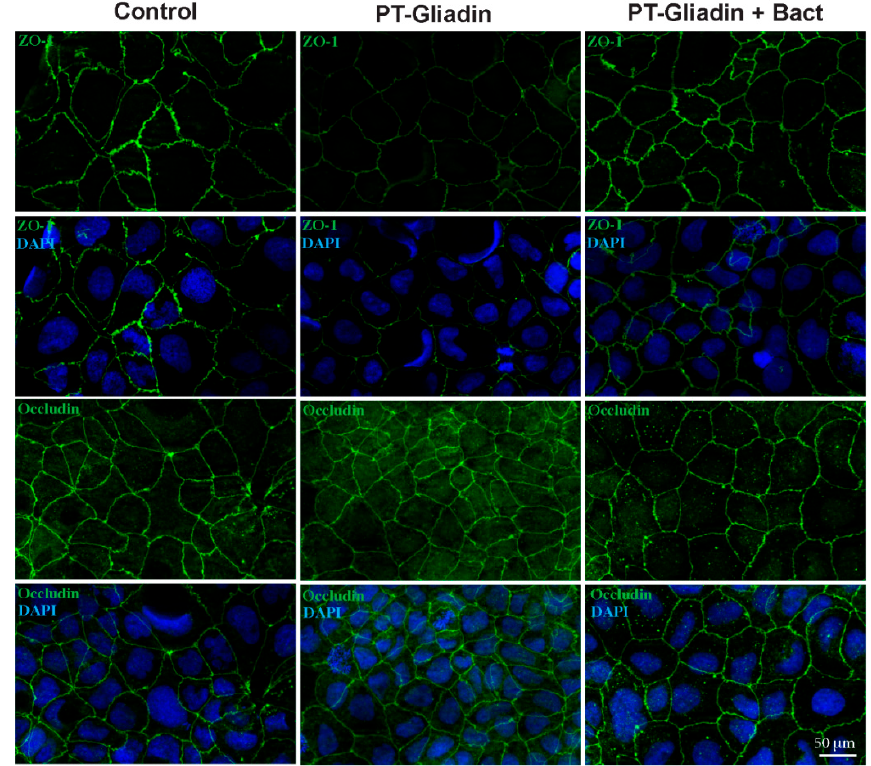
Figure 6. Caco-2 cells stained for zonulin (ZO-1) or occludin. Cells were treated with 1 mg / mL of PT-gliadin or PT-gliadin + bact and, after 3 h of treatment, cells were fixed and stained with antibodies against ZO-1 or occluding, and with 4 ′ ,6-diamidino-2-phenylindole (DAPI) to counterstain nuclei. Bar, 50 μ m.